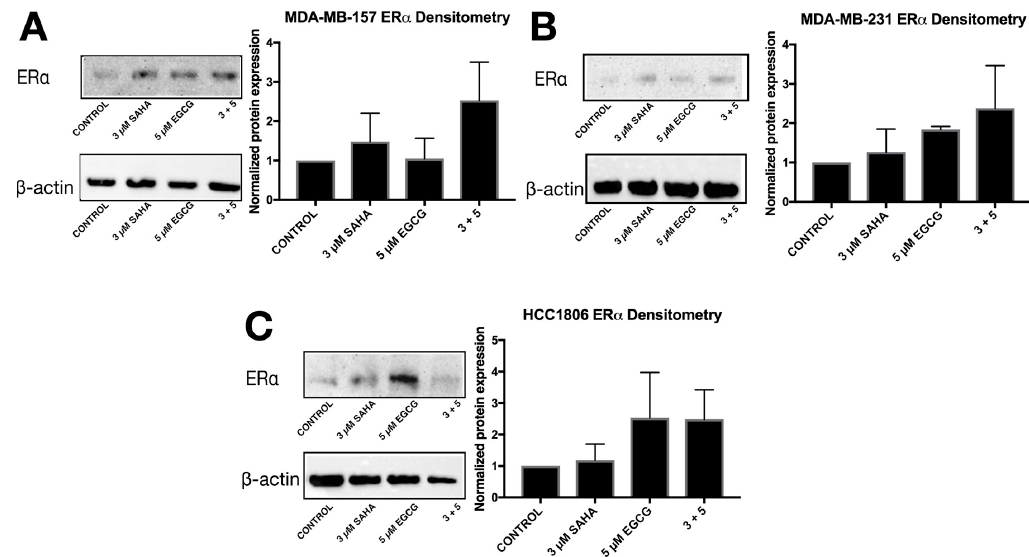
Figure 8. SAHA + EGCG upregulated estrogen receptor alpha (ER α ) in all three TNBC cell lines. ( A ) After 72 h of treatment with SAHA and/or EGCG, protein was extracted from MDA-MB-157 cells. Cells were probed with ER α primary antibodies (Santa Cruz, Dallas, TX, USA) before imaging. β -actin was used as the control. ( B , C ) The same was done in MDA-MB-231 and HCC1806 cell lines. Pictures are representative while densitometry analysis is an average of all replicates ( n = 3). The same blots were probed multiple times, explaining the duplication of β -actin between